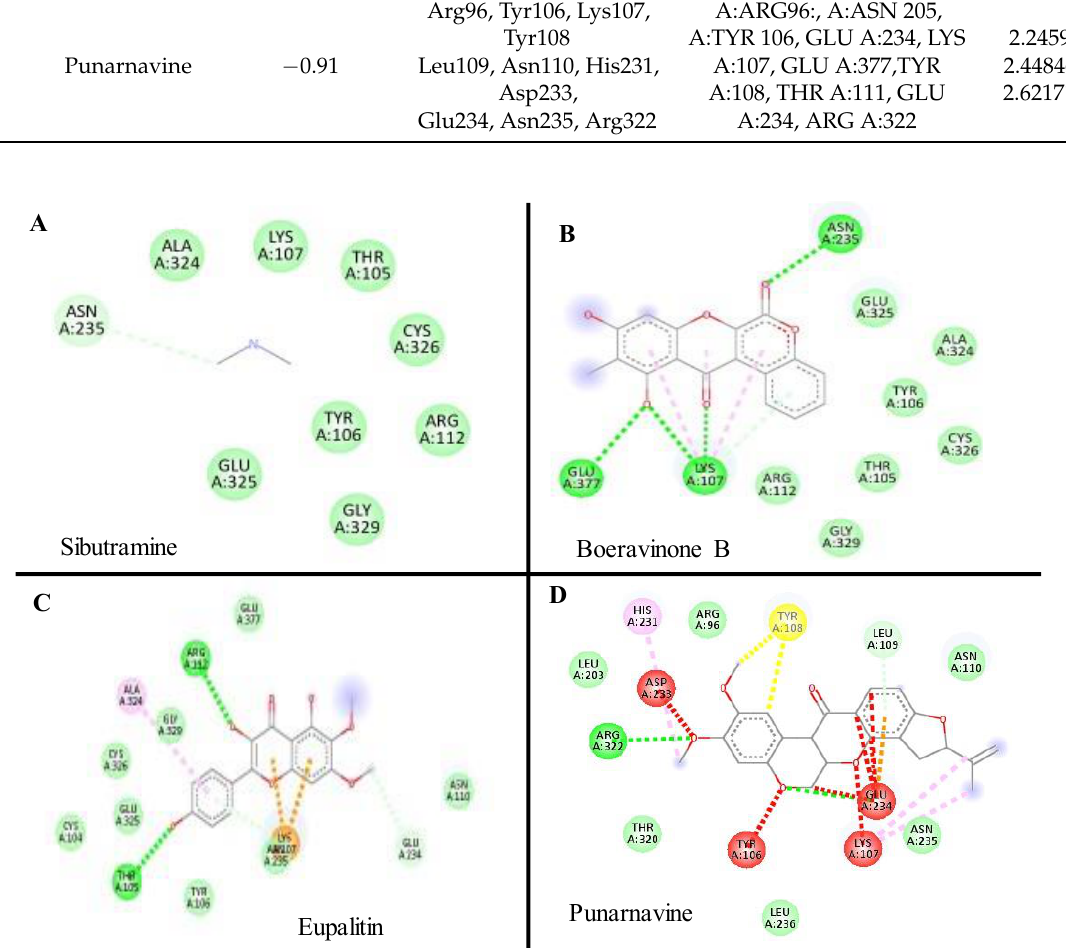
Figure 2. The docked complexes of selected compounds ( A ) Sibutramine, ( B ) Boeravinone B, ( C ) Eupalitin, and ( D ) Punarvavine with Cannabinoid receptor.